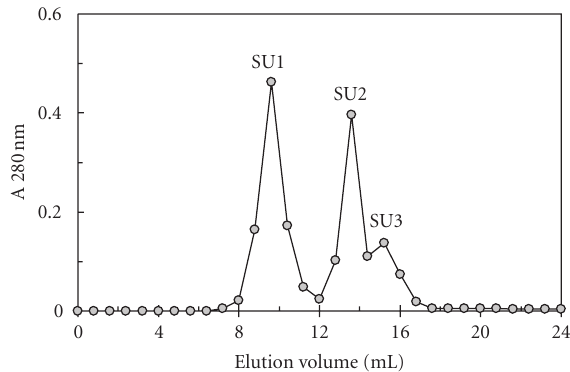
Figure 2: FPLC gel filtration on Superdex 75 hR 10/30 column. Sample: fraction CM2. Bu ff er: 0.2M NH 4 HCO 3 bu ff er (pH 8.5). Fraction size: 0.8 mL. Flow rate: 0.4 mL/min.